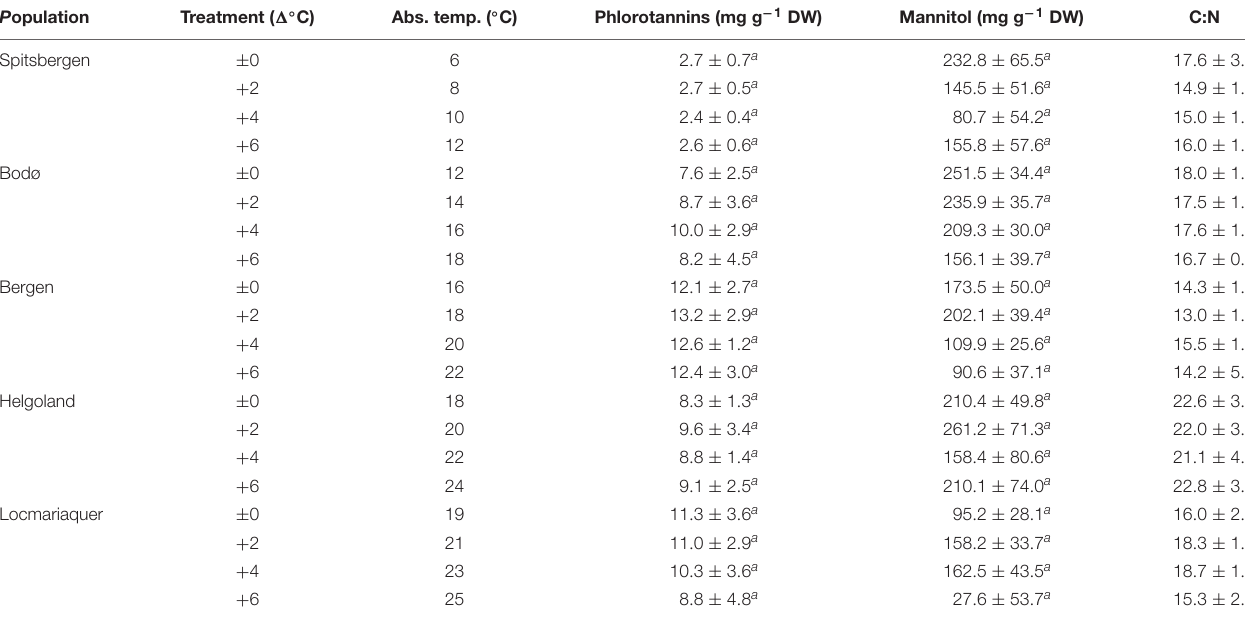
TABLE 3 | Phlorotannins, mannitol and C:N ratio of S. latissima across latitudes in Europe after the temperature-amplitude experiment. P opulation Treatment ( (cid:49) ◦